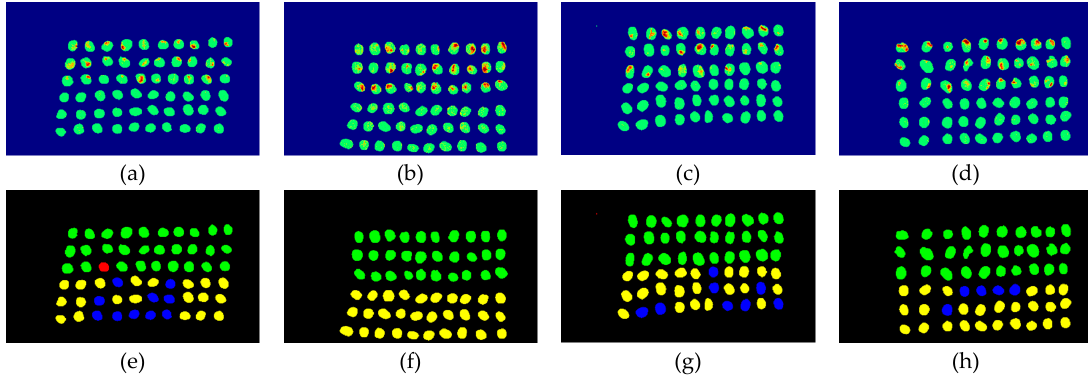
Figure 28. Results of green coffee bean CEM-SVM+ MinV_BP 10 bands. ( a–d ) SVM classification results, ( e–h ) final visual images.